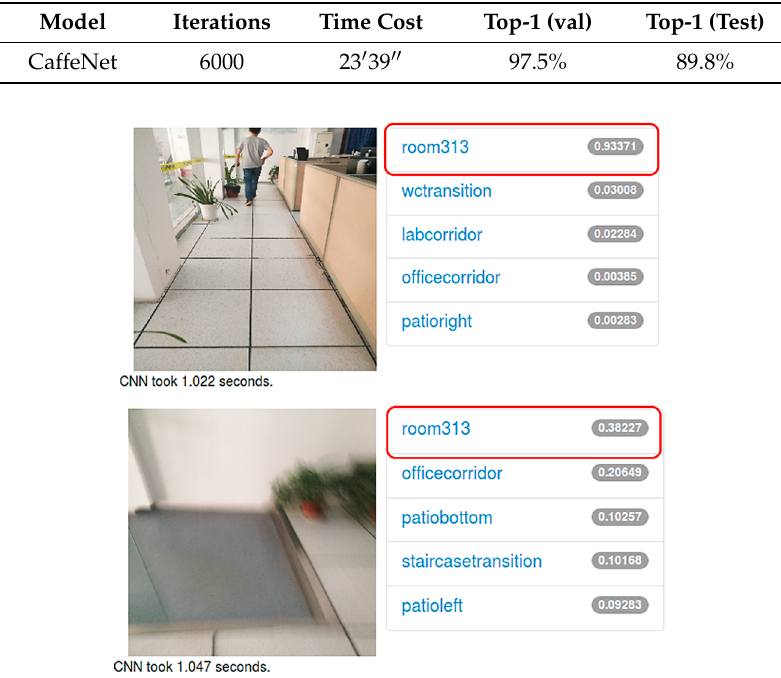
Table 3. Score of model for indoor scene recognition.